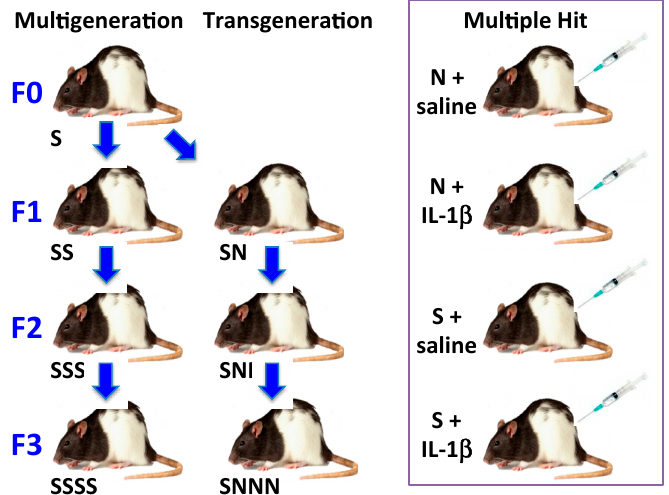
Figure 2. Allostatic load models in pregnant Long-Evans rats. We developed two longitudinal models, a multigenerational ( left ) and a transgenerational model ( center ), and a single generation (all F0) multiple hit model ( right ) that result in preterm birth plus other adverse pregnancy outcomes. In the multigenerational model, pregnant dams in each generation are subjected to restraint and swim stresses (S) on gestational day (GD) 12–18. The transgenerational model differs in that only pregnant dams from the F0 generation are stressed; their daughters and granddaughters are not stressed (N) during their pregnancies. In the multiple hit model, pregnant dams are stressed (S) or not (N) as in the longitudinal models plus they receive an intraperitoneal (IP) injection of saline or IL-1 β (5 μ g/kg) daily from GD 17 to delivery.